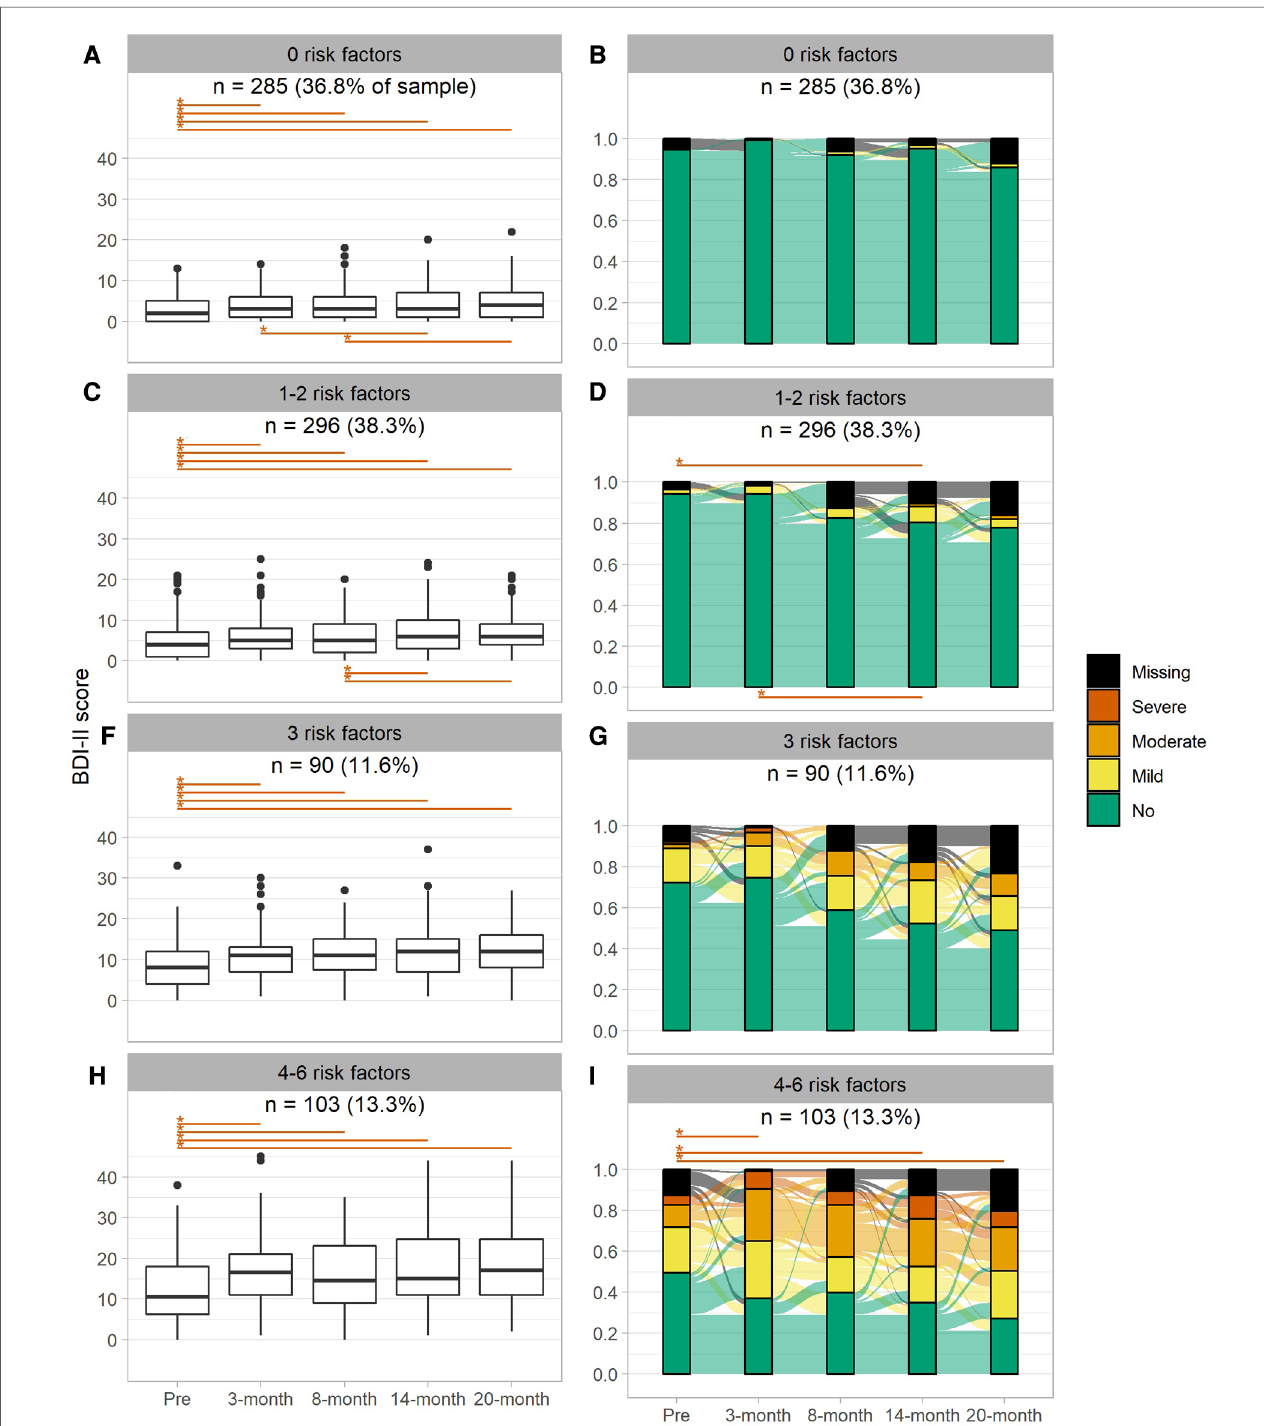
deterioration, blue: improvement). Tests in the alluvial diagram are based on categorized data as shown in the